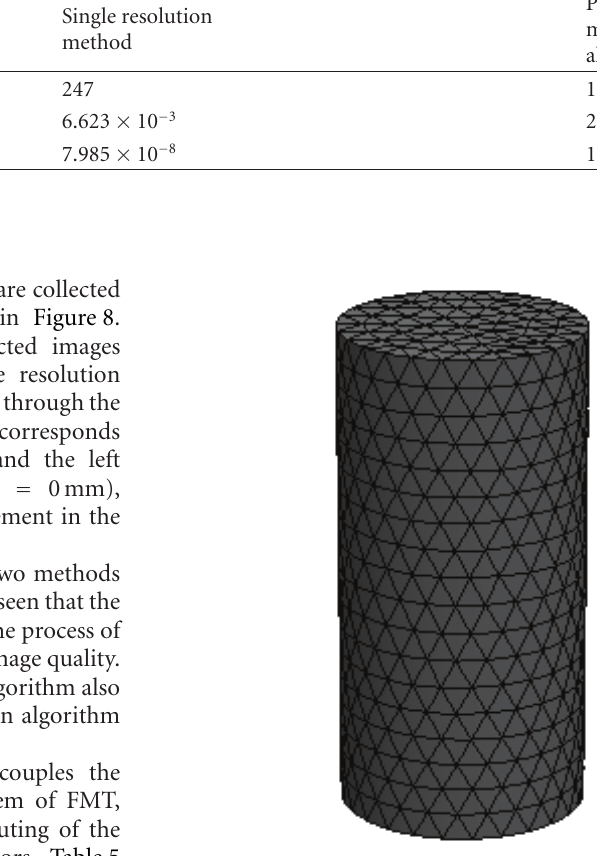
Figure 9: 3D mesh for image reconstruction with 858 nodes and 3208 tetrahedral elements.